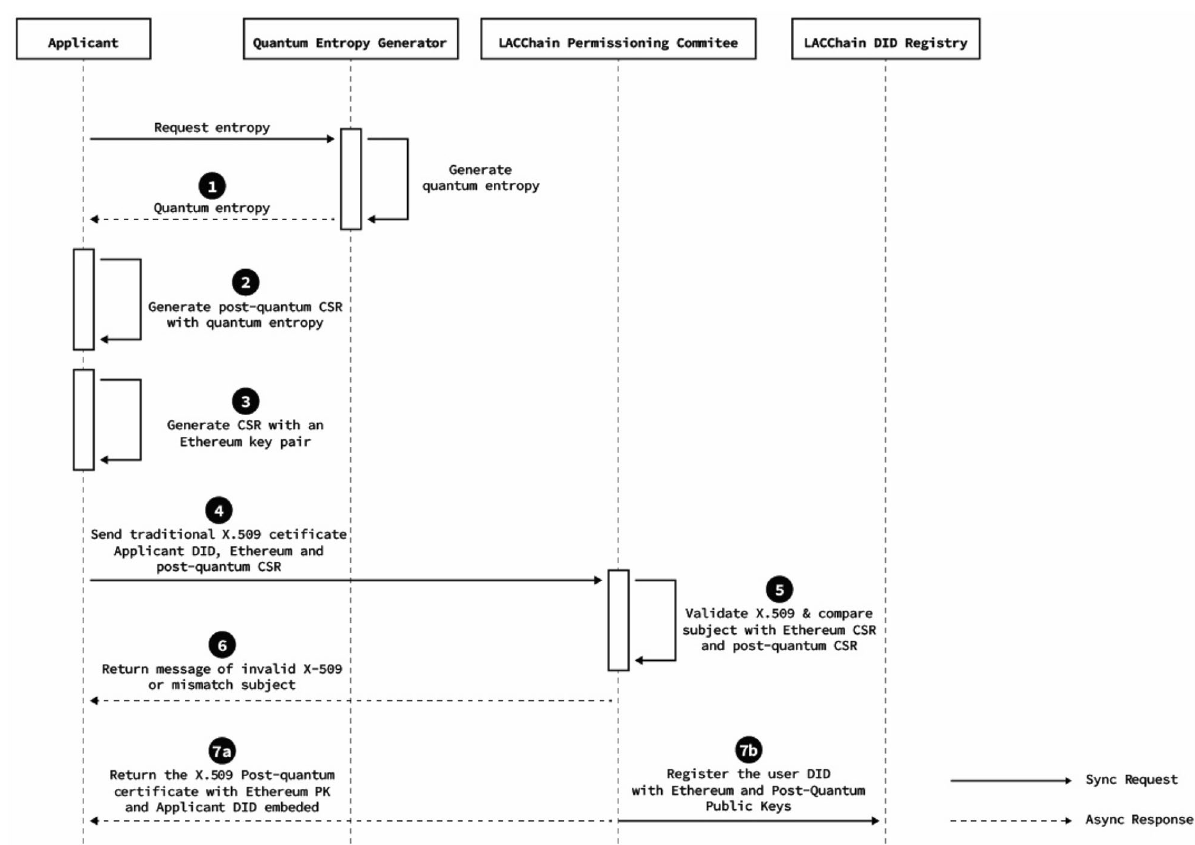
Figure 4. High level diagram of the post-quantum certification and on-chain registration of an